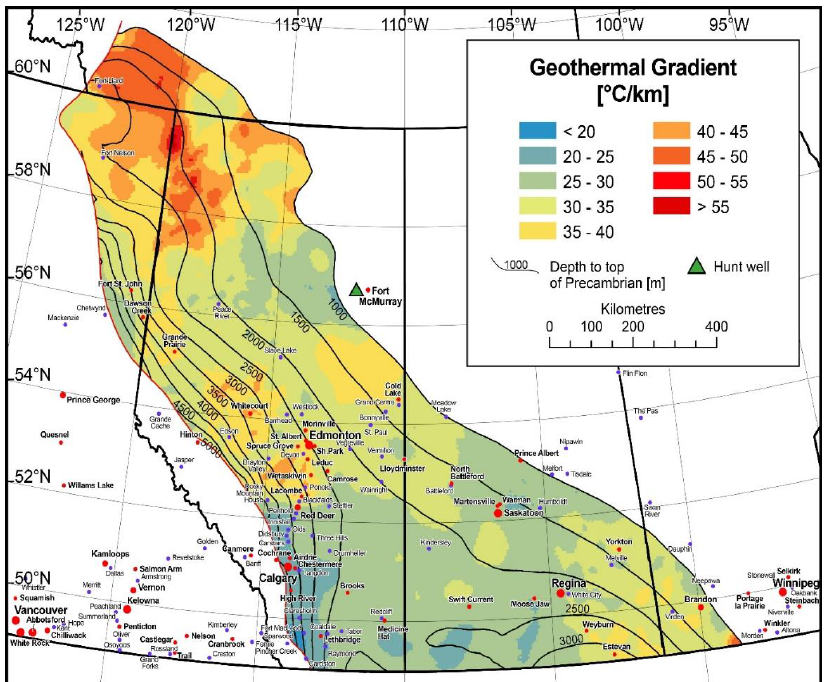
Figure 5. The communities’ studies here shown against the map of average geothermal gradient for the WCSB with sediment thickness >1000 m. The red line is the western boundary of the WCSB marked by the Rocky Mountains disturbed belt modified from [16]. The Hunt well near Fort McMurray is the site of first heat flow determined below the WCSB, in an interval of the 0.5–2.4 km in Precambrian granites [33]. Since geothermal gradient is defined by Equation (1):